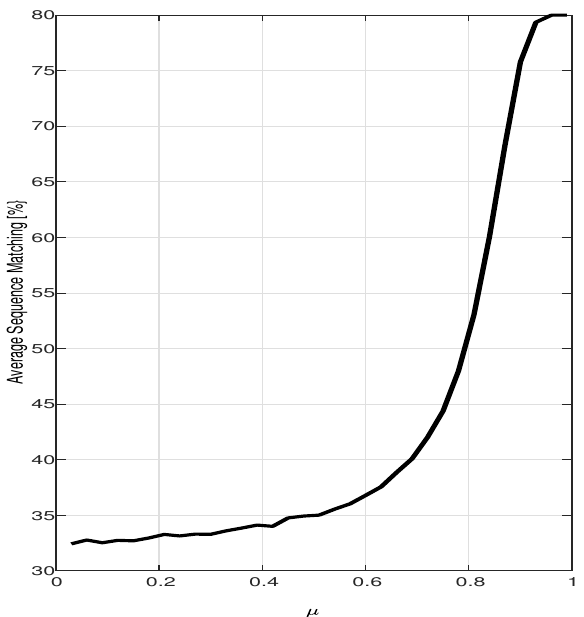
Figure 2. Average sequence matching given a length—16